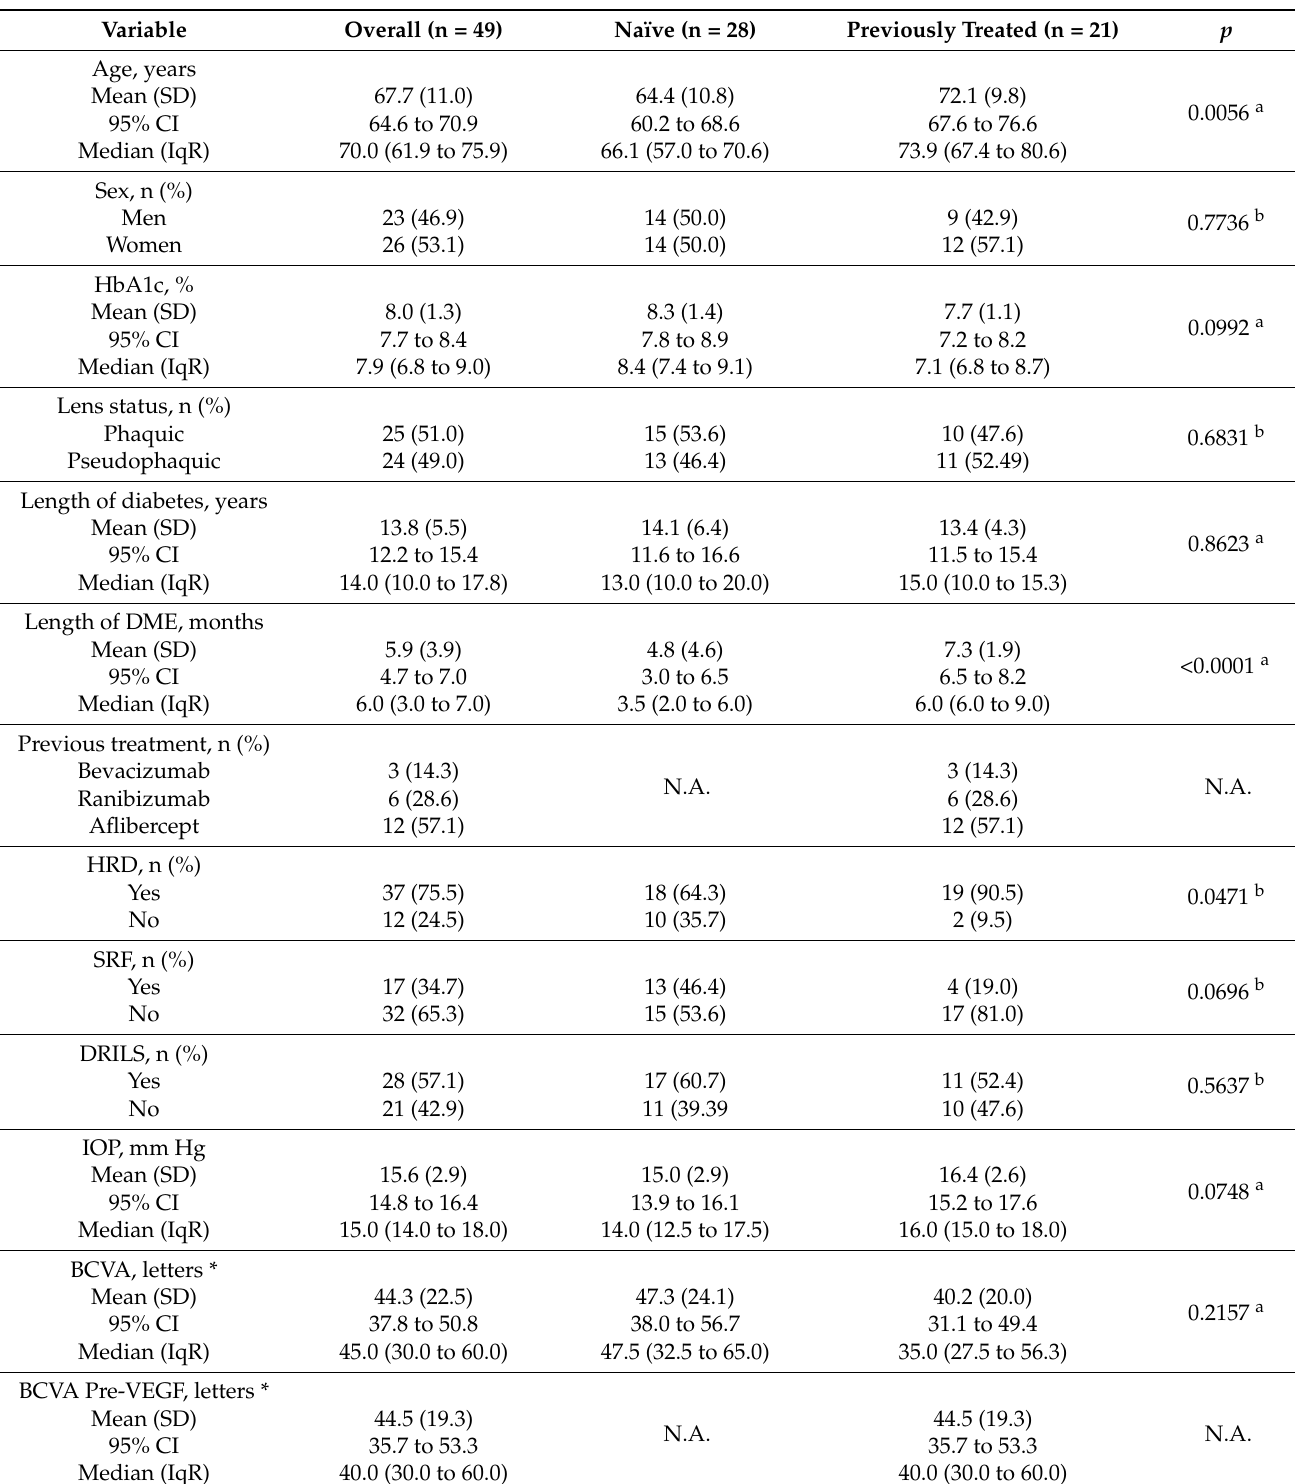
Table 1. Main demographic and clinical characteristics of the study